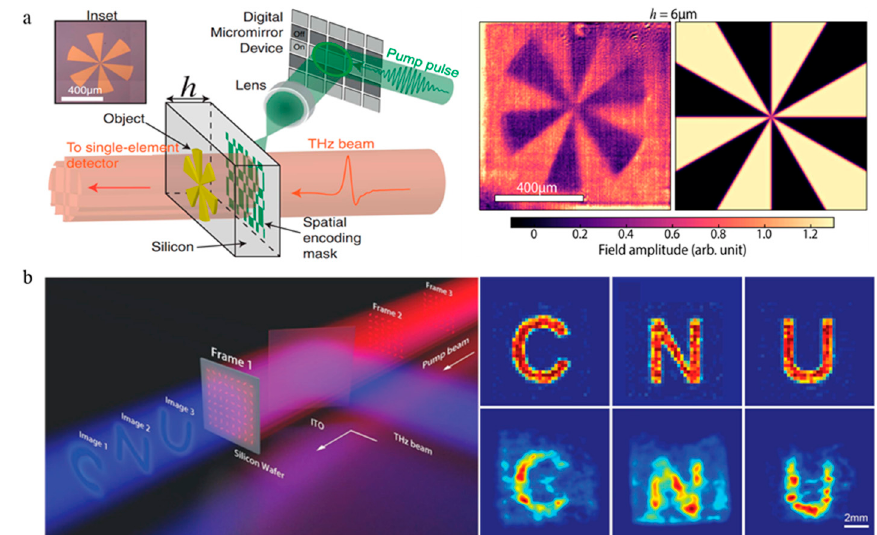
Figure 8. ( a ) Modulation imaging using digital micromirror equipment, which spatially modulates a coincident THz pulse. The terahertz waves of a sample are then measured by a single detector and the imaging result of a 6-µm-thick silicon wafer. Reproduced with permission from [67]. ( b ) Schematic representation of pure phase spatial THz modulator; and theoretical and experimental effects of dynamic holograms. Reproduced with permission from [72], copyright John Wiley and Sons, 2019.